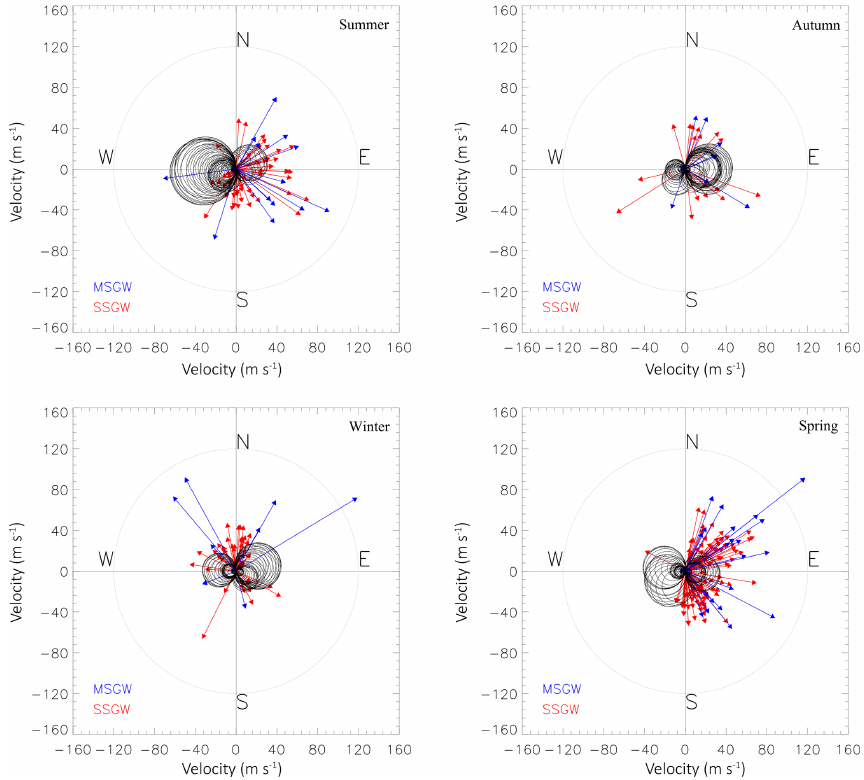
Figure 8. Seasonal blocking diagram superimposed with phase speed and the azimuthal angles of SSGWs and MSGWs. The shaded area indicates the magnitude and direction of the restricted region for wave propagation to OH heights. The red and blue arrows show the magnitude and direction of the SSGWs and MSGWs motions, respectively, observed during each season in